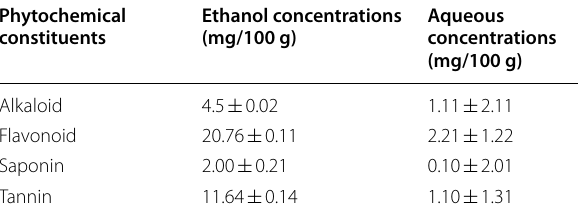
Values are the mean